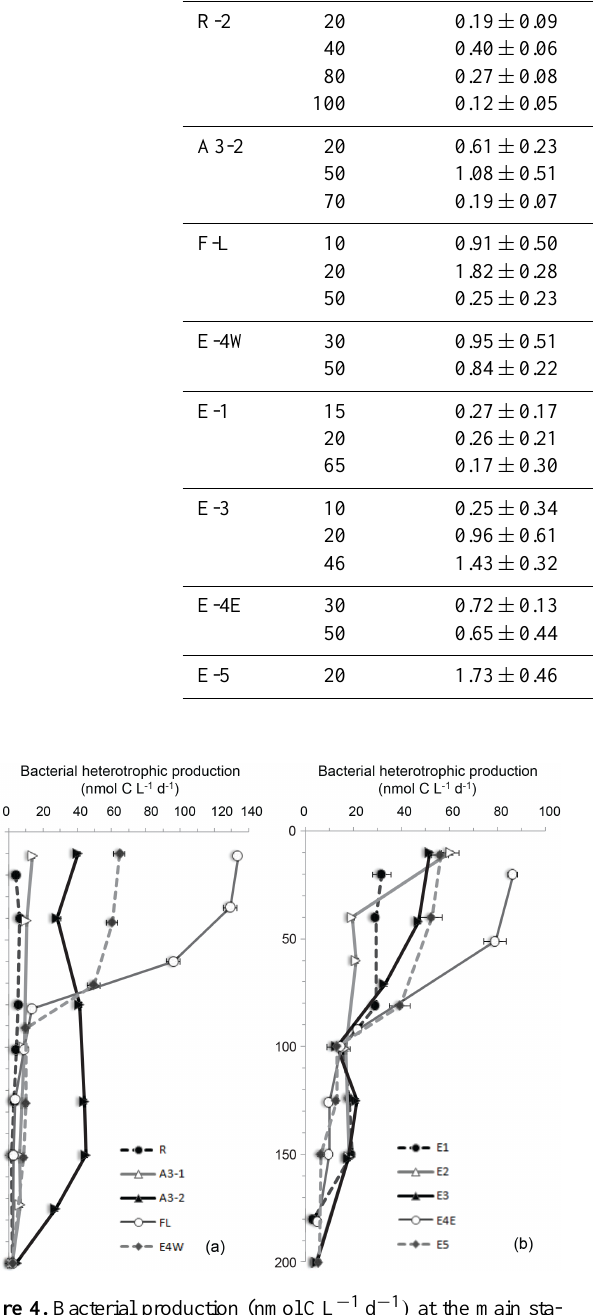
Figure 4. Bacterial production (nmolCL − 1 d − 1 ) at the main sta- tions in the 0–200m layer. Station R; A3-1, and 2; F-L, and E- 4W (a) ; and “E” stations (b)